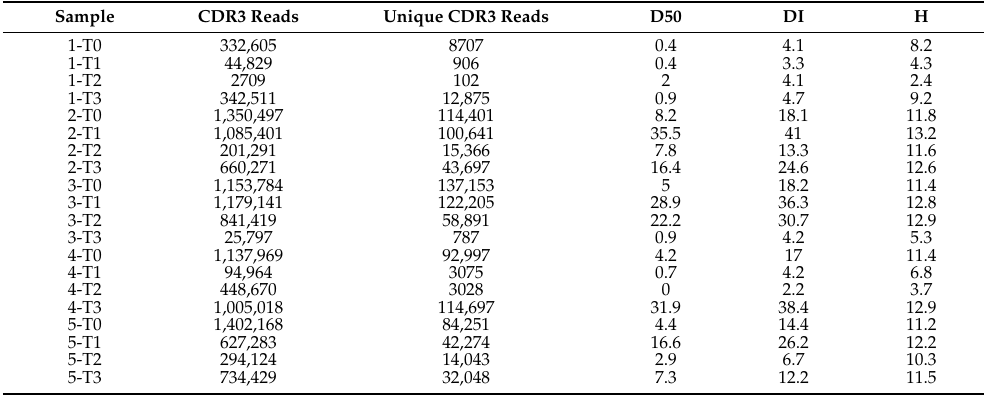
Table 3. Longitudinal follow-up of pre- and post-transplantation changes in CDR3 sequence expres- sion, as well as their immune diversity